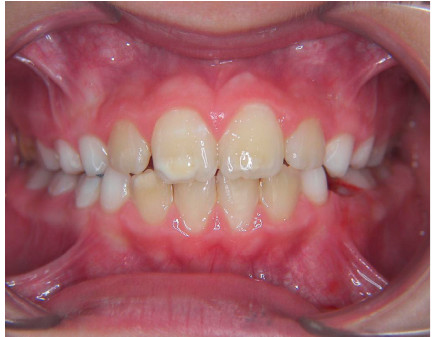
Figure 3: Mild incisor hypomineralization.